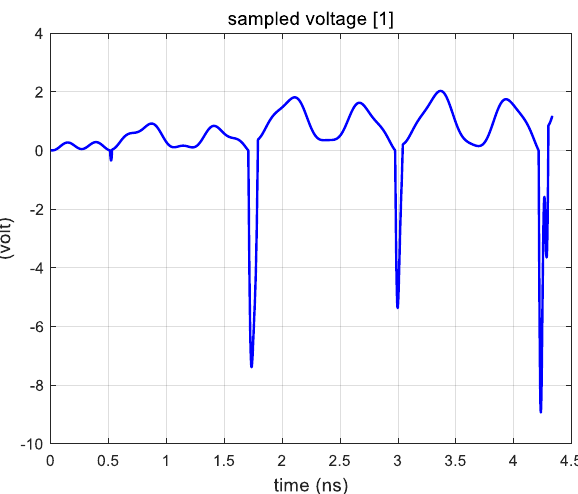
Figure 15. Results for the improved equivalent circuit method.